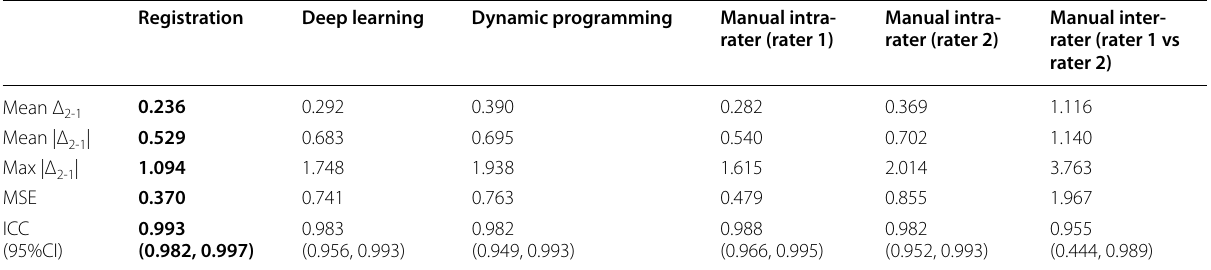
Table 3 Comparison of test‑retest reproducibility of MagDensity derived using different segmentation methods